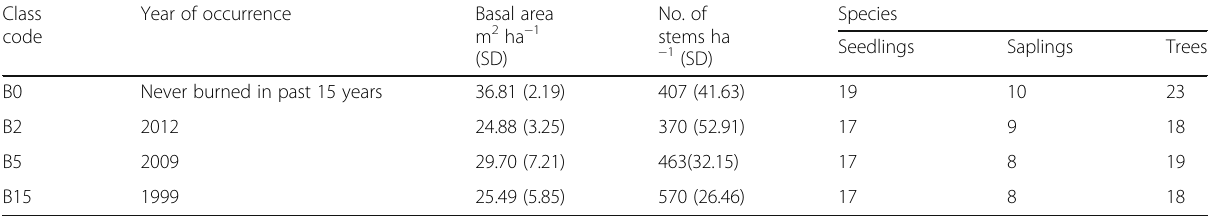
Table 1 Description of site characteristics: year of burn, species richness, basal area, and stem density Class